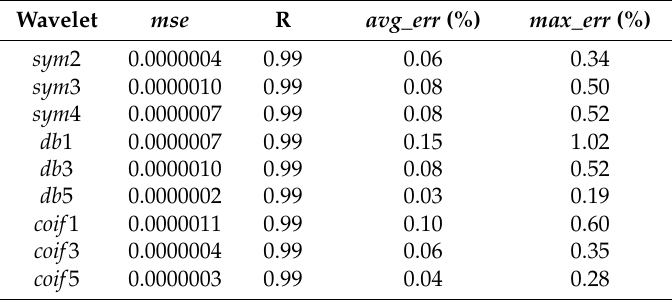
Table 2. Performance of the wavelet functions and the effect of this factor on the accuracy of the proposed model.